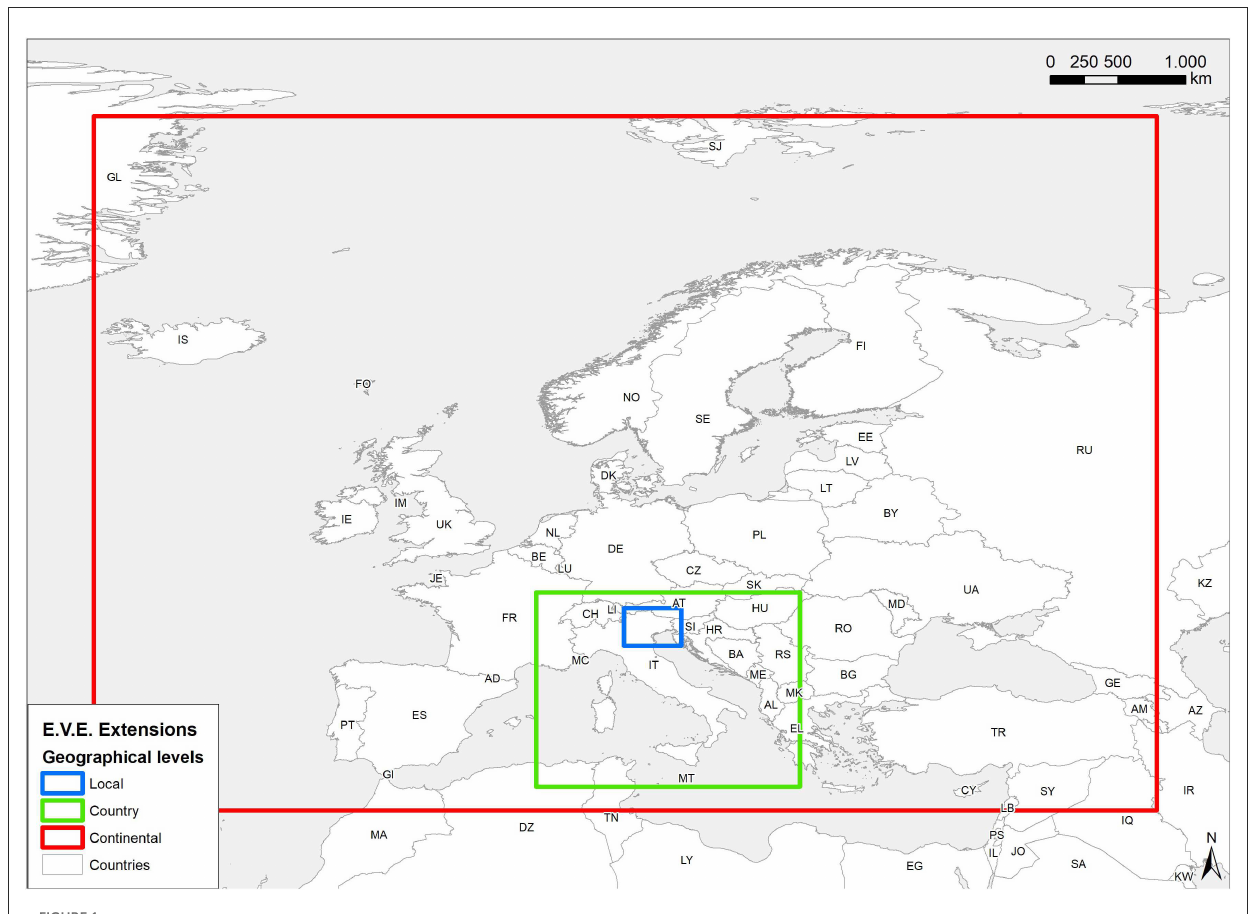
FIGURE1 Extent for different geographical levels: local, country,